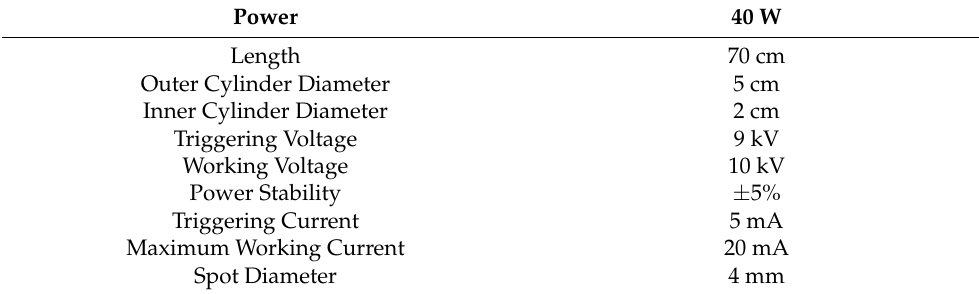
Table 1. Specifications of sealed laser